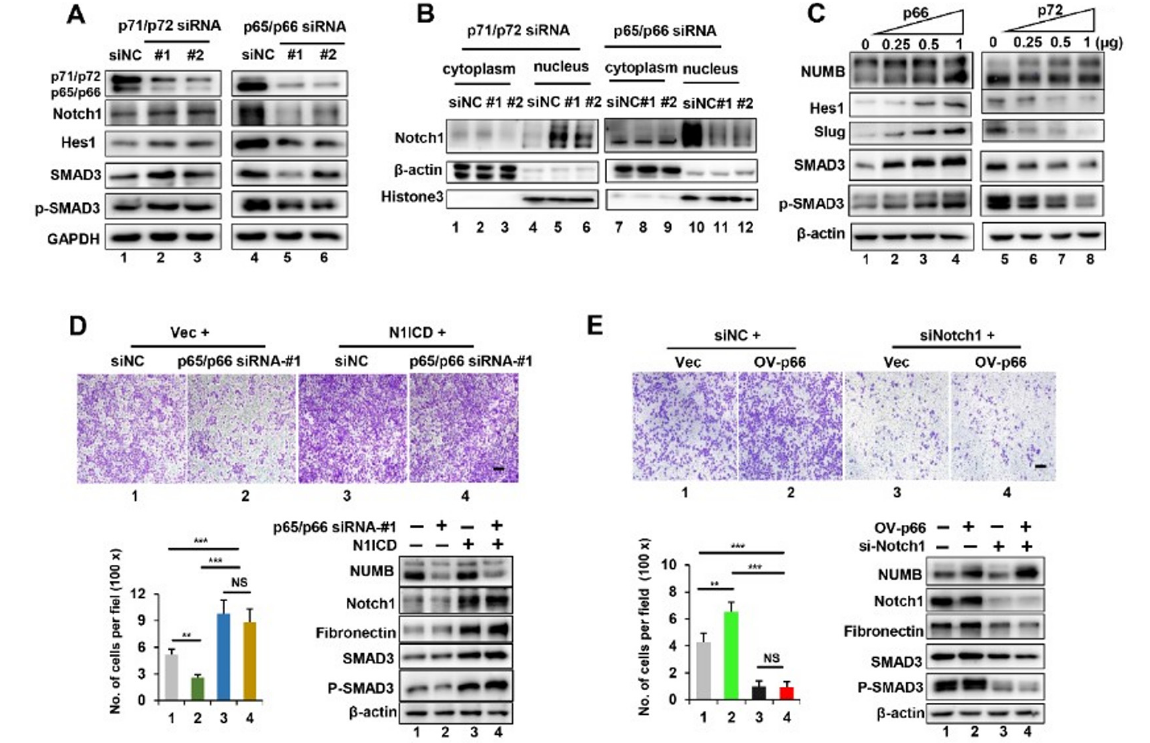
Figure 4. Notch1 activation is required for p65/p66-induced EMT and tumor cell migration. ( A ) RKO cells were transiently transfected with siNC and p71/p72 siRNA (#1 or #2), and HeLa cells were transiently transfected with siNC and p65/p66 siRNA (#1 or #2), followed by Western blotting analysis using indicated antibodies. GAPDH was used as loading controls. ( B ) Nuclear and cytoplasmic proteins were separately isolated from cells described in ( A ) and subjected to Western blotting analysis. β -actin and histone3 were used as loading controls. ( C ) RKO cells were transiently transfected with increasing amounts of a p66-expression plasmid, and HeLa cells were transfected with a p72-expression plasmid, followed by Western blot analysis with indicated antibodies. ( D ) HeLa cells were co-transfected with p65/p66 siRNA-#1 and an N1ICD-expression plasmid as indicated, followed by the cell migration assay. Representative images of migratory cells stained with crystal violet are shown (top). Scale bar is 200 µ m. Quantification of migratory cells is shown as mean ± SD on the left bottom, and Western blot analysis with indicated antibodies is shown on the right bottom. ( E ) HeLa cells were co-transfected with anti-Notch1 siRNA (siNotch1) and a p66-expression plasmid as indicated, followed by the cell migration assay. Representative images of migratory cells stained with crystal violet are shown (top). Scale bar is 200 µ m. Quantification of migratory cells is shown as mean ± SD in the bottom left, and Western blot analysis is shown in the bottom right. ** p < 0.01, *** p < 0.001, NS p >